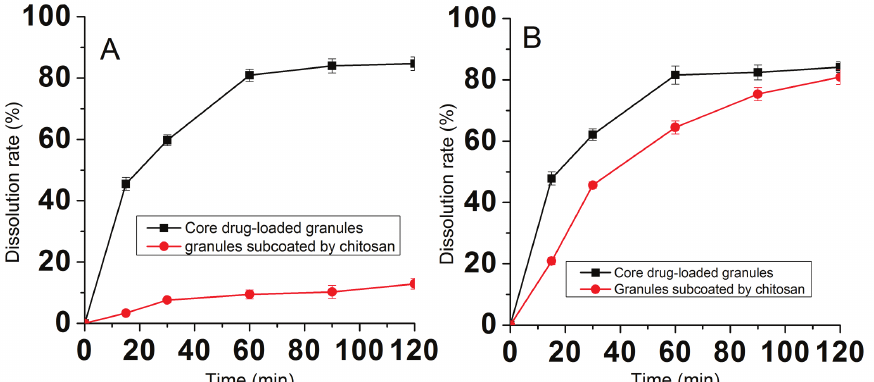
FIGURE 1 - The dissolution profiles of core drug-loaded granules and granules subcoated by chitosan in pH 7.4 with the obsence of rat cecal contents (A) and presence of rat cecal contents